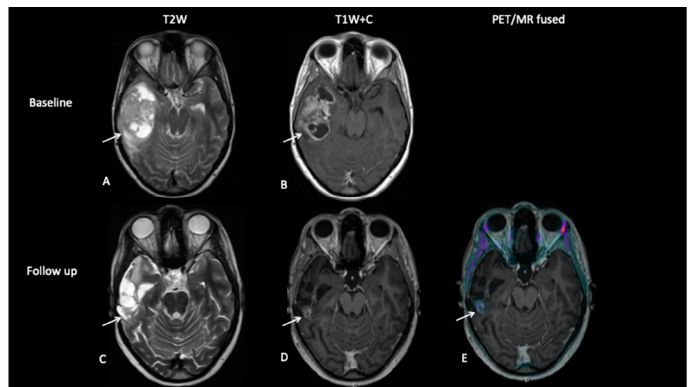
Figure 8. Baseline imaging demonstrates a large heterogenous right temporal lobe tumour ( A ) with avid enhancement ( B ). Follow-up imaging demonstrates the post-surgical resection on the T2W image ( C ) with nodular enhancement at the deep surgical margin ( D ), suspicious for residual tumour, but there is no increased uptake on FCho ( E ).